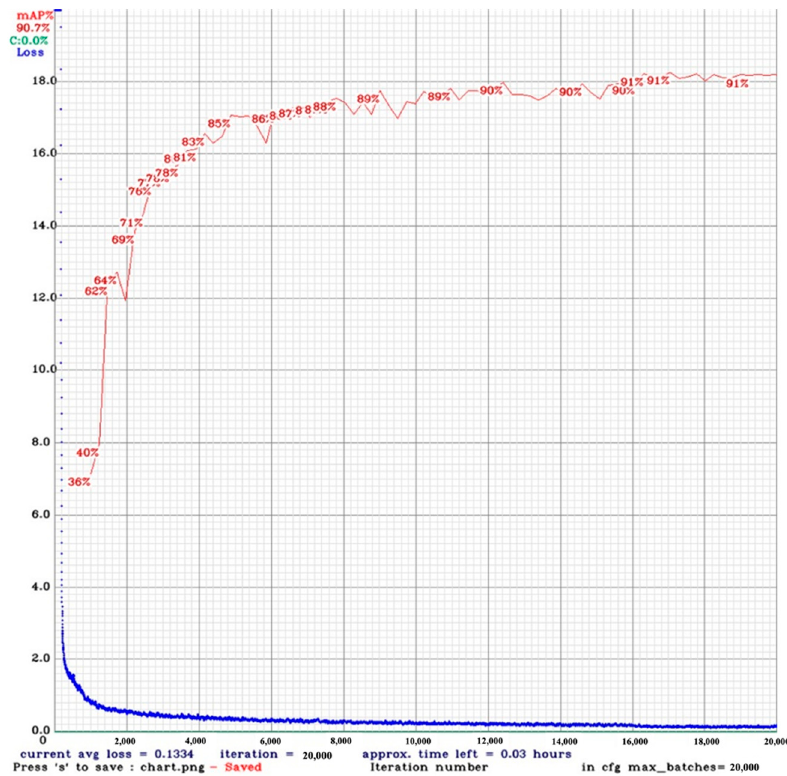
Figure 4. Training process of the modified Yolov3. The simulation scheme was 384 × 384 input size, two detection scales, and 30% filter reduction. The red line and blue line represent the mAP and training average loss, respectively.